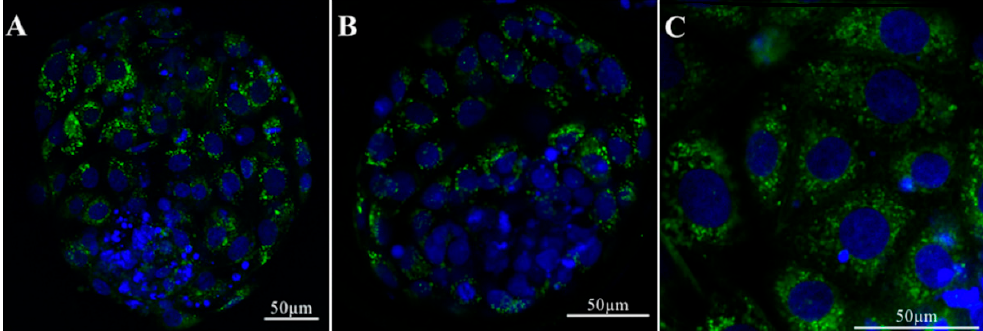
Figure 4. Incorporation of bovine oEVs into the blastocyst. ( A – C ) oEVs from bovine oviducts labeled with green fluorescent dye (PKH67) are incorporated into cytoplasmic contents in the bovine blastocyst. ( C ) High magnification image shows that in vivo-derived oEVs attach to the blastocyst plasma membrane and are internalized into the cytoplasm. Hoechst 3342 staining; nucleus. Reprint with permission from [24].